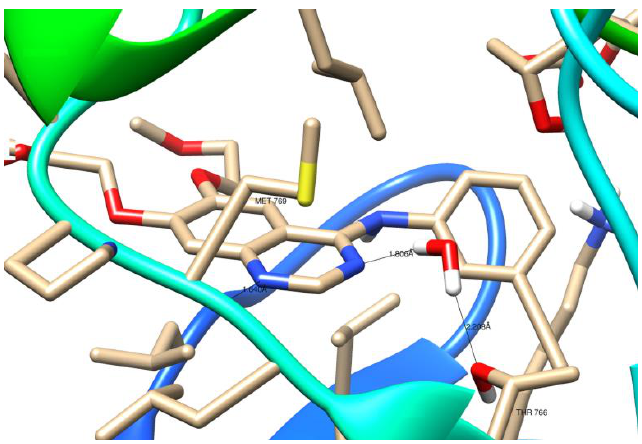
Figure 11. Three-dimensional (3D) binding interaction of erlotinib with EGFR (PDB ID: 1M17).